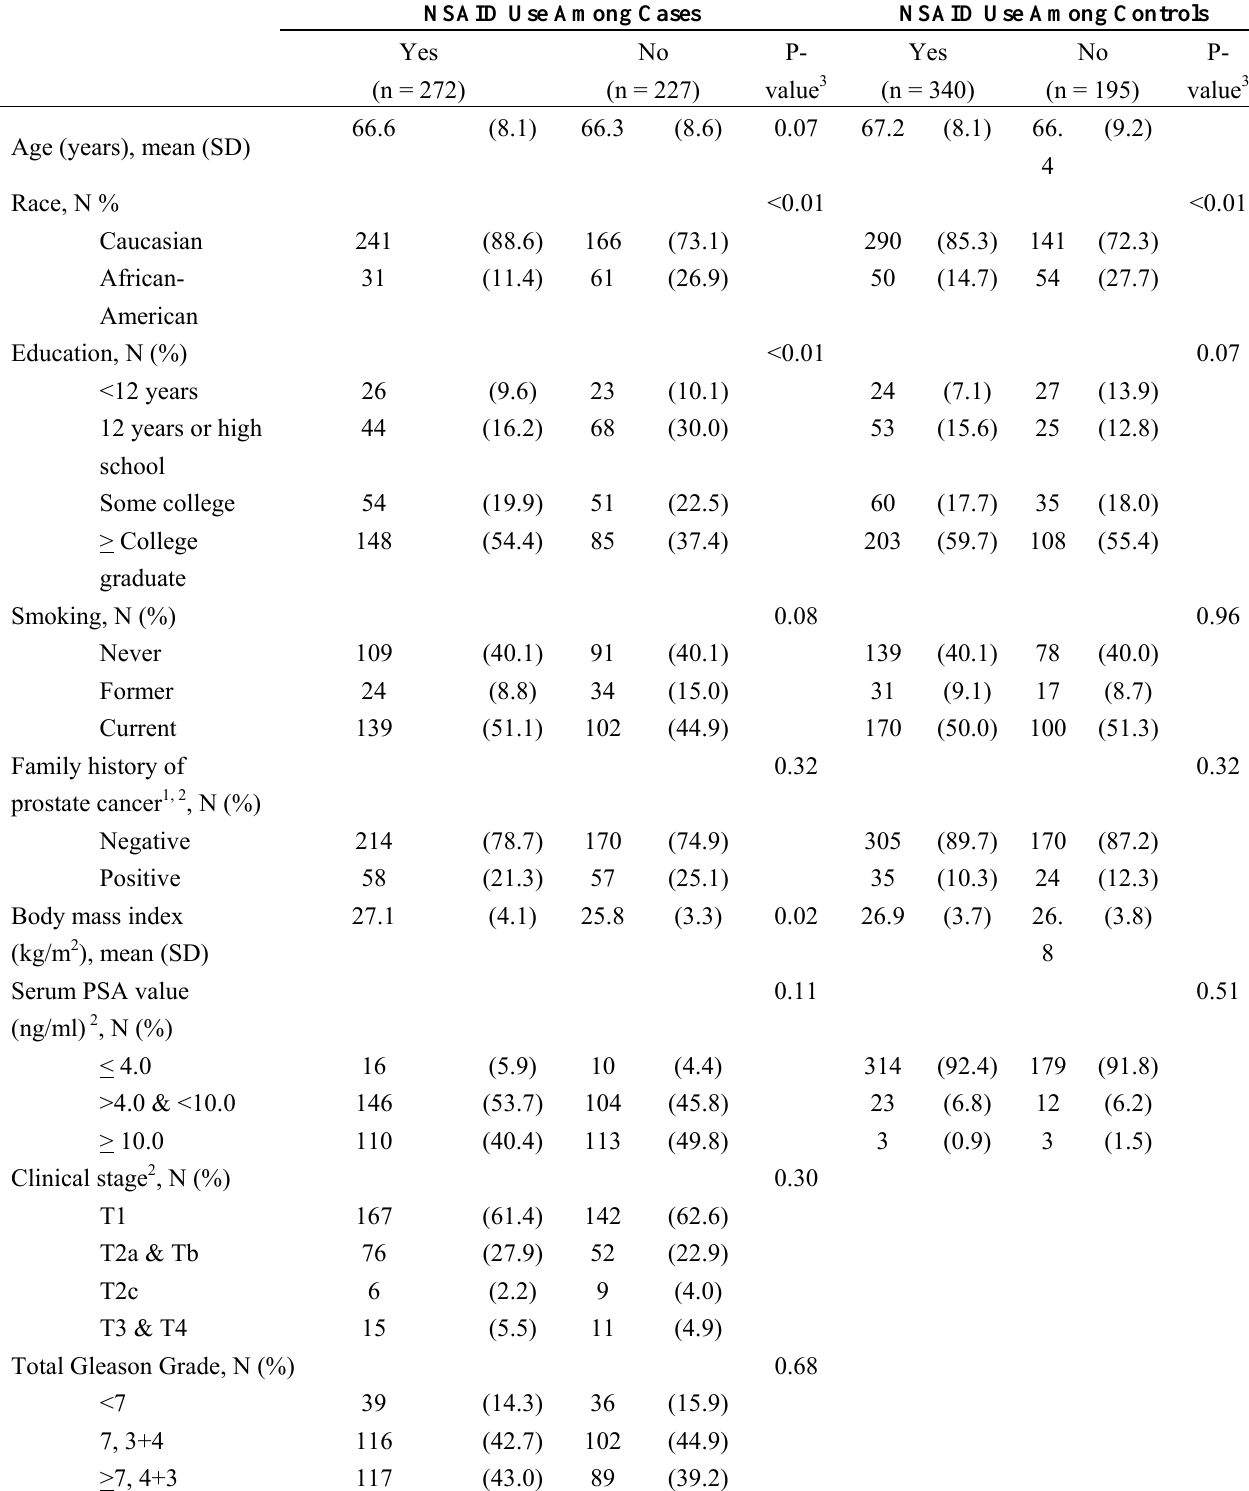
Table 2 . Characteristics of Aggressive Prostate Cancer Cases (NSAID users compared to